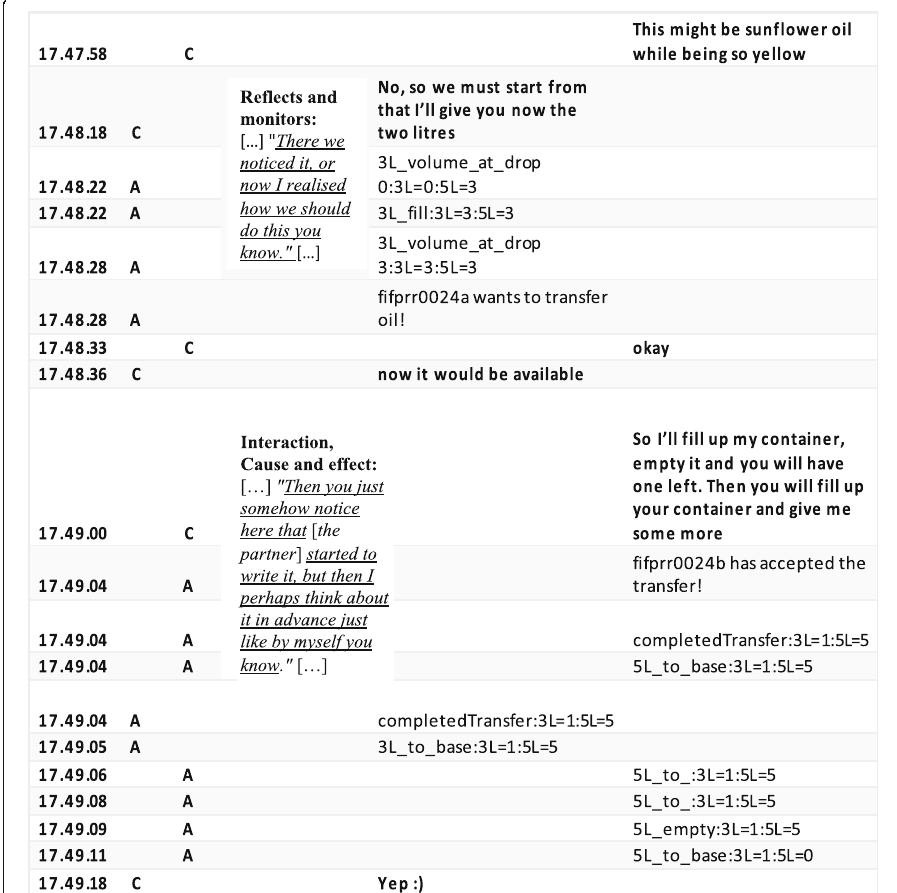
Fig. 8 Balanced CPS process in terms of the dynamics of interaction (pair 24, Olive Oil). The excerpt includes a time-stamped, condensed activity pattern (A = action, C = chat); dialogue extracted from the activity log, and the speech bubbles contain excerpts from the coded CRR data. (Translated from